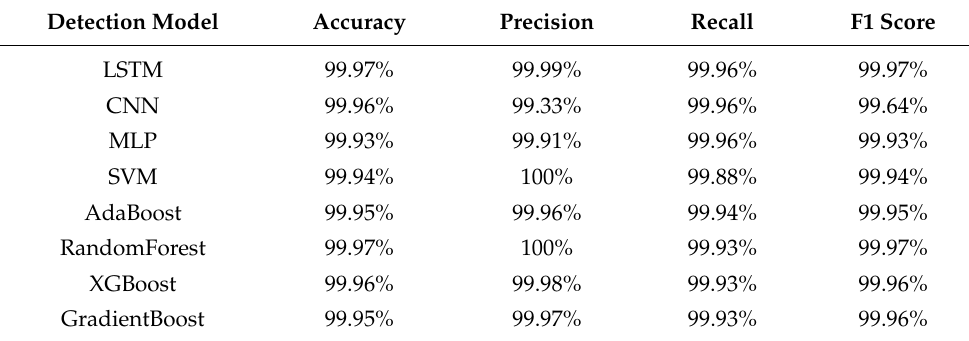
Table 8. The performance of original detection